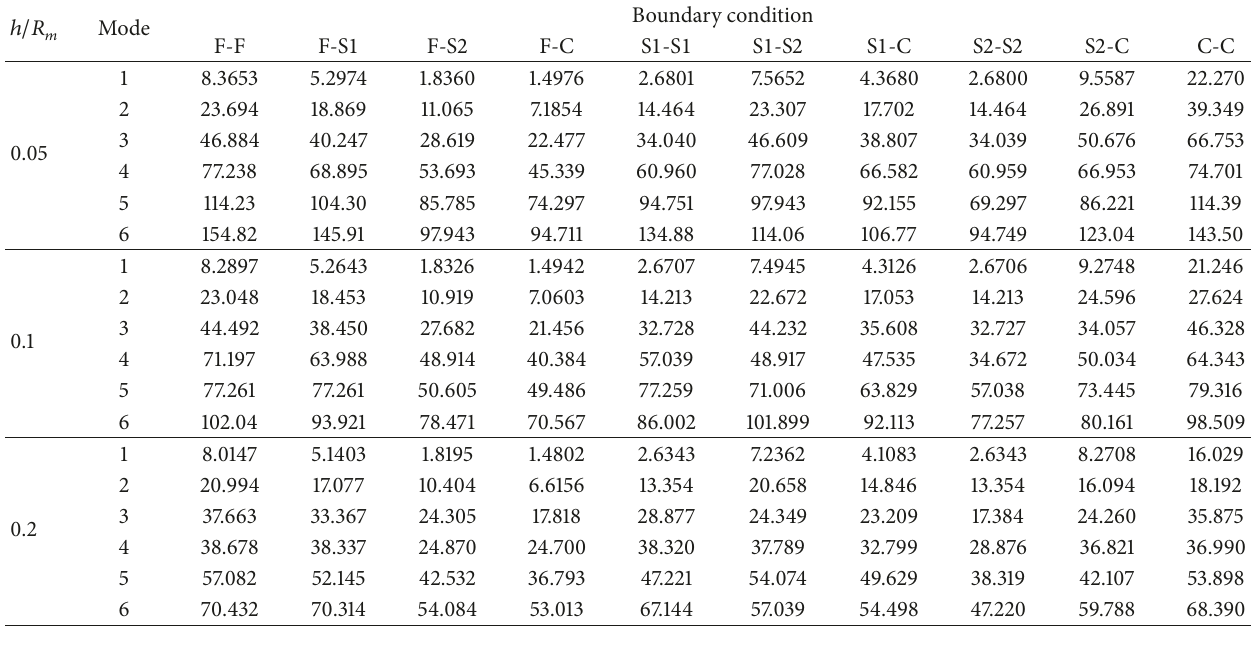
Table 4: The lowest six frequency parameters Ω of classically restrained circular beams with various thickness ratios ( 𝑅 𝑚 = 1 m, Δ𝜃 = 𝜋/2 ). ℎ/𝑅 𝑚 Mode